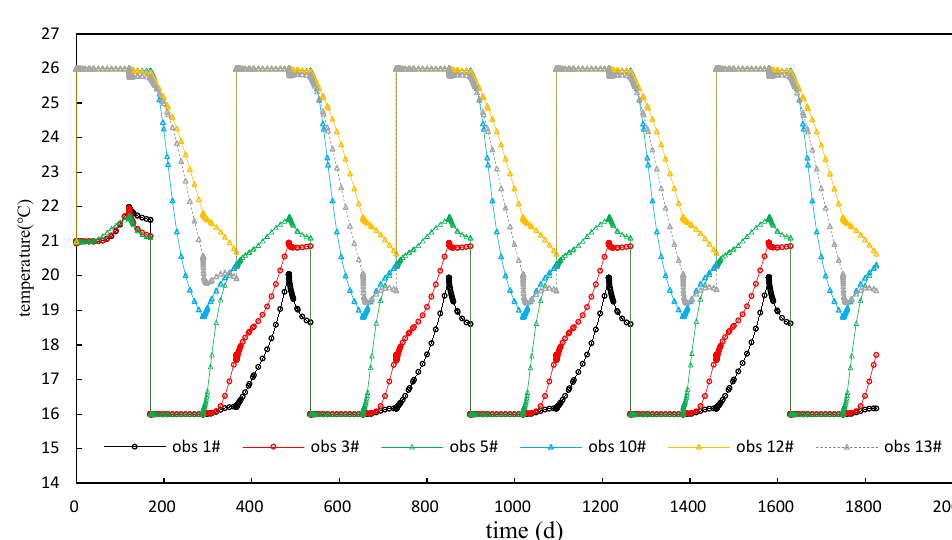
Figure 9. Temperature vs. time for observation wells (F3).